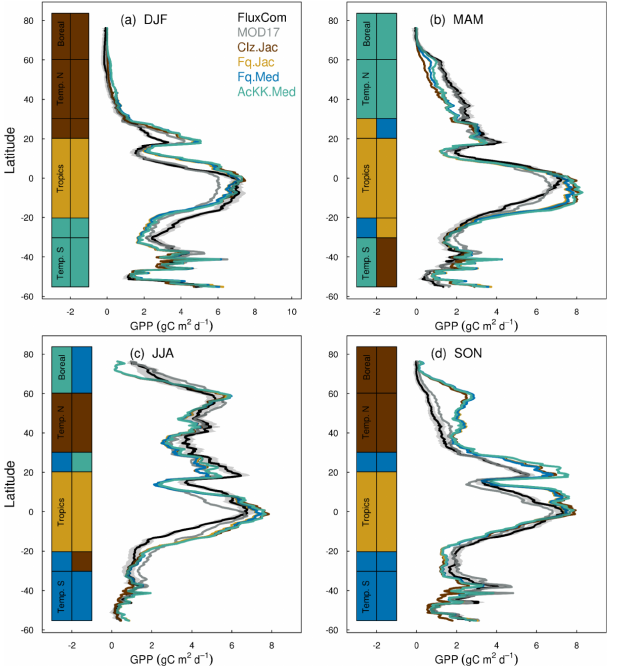
Figure 5. Mean (2002 to 2012) evapotranspiration (ETmmd − 1 ) by latitude band and season for each JULES model configuration com- pared to the FluxCom and GLEAM global ET products. The bars along the side indicate which model configuration gives the lowest RMSE and therefore better comparison to FluxCom (righthand bar) and GLEAM (left-hand bar) derived ET for each region. RMSE val- ues are shown in Table S6 (FluxCom) and Table S7 (GLEAM). The grey shaded area shows the uncertainty in the FluxCom ET prod- uct, provided as the median absolute deviation of ensemble mem- bers, this is scaled to a robust estimate of the standard deviation of a normal distribution by multiplying by 1.4826 according to Jung et al.